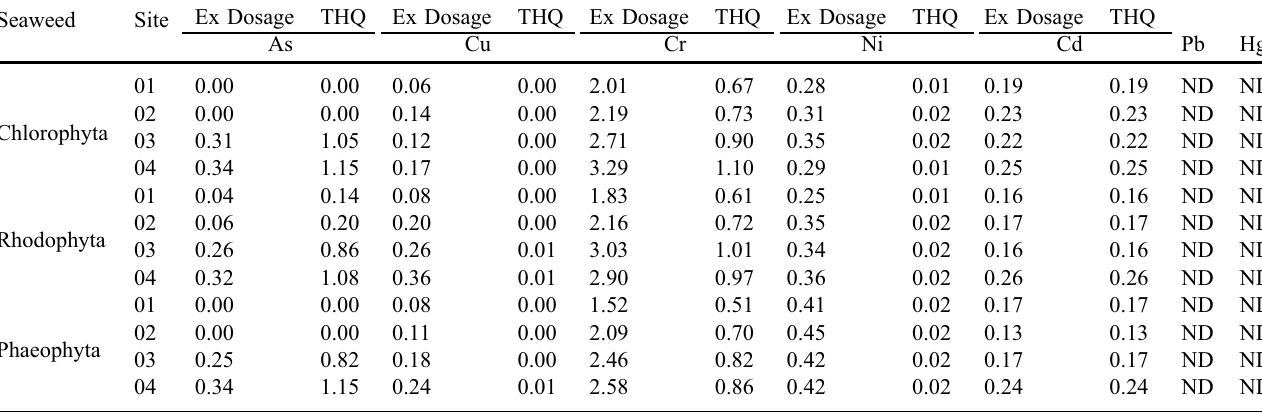
Table 3. Concentration in mg kg (cid:1) 1 of metals and metalloids in three varieties of seaweeds in different coastal areas of Sri Lanka (cid:1) North East Monsoon Season.